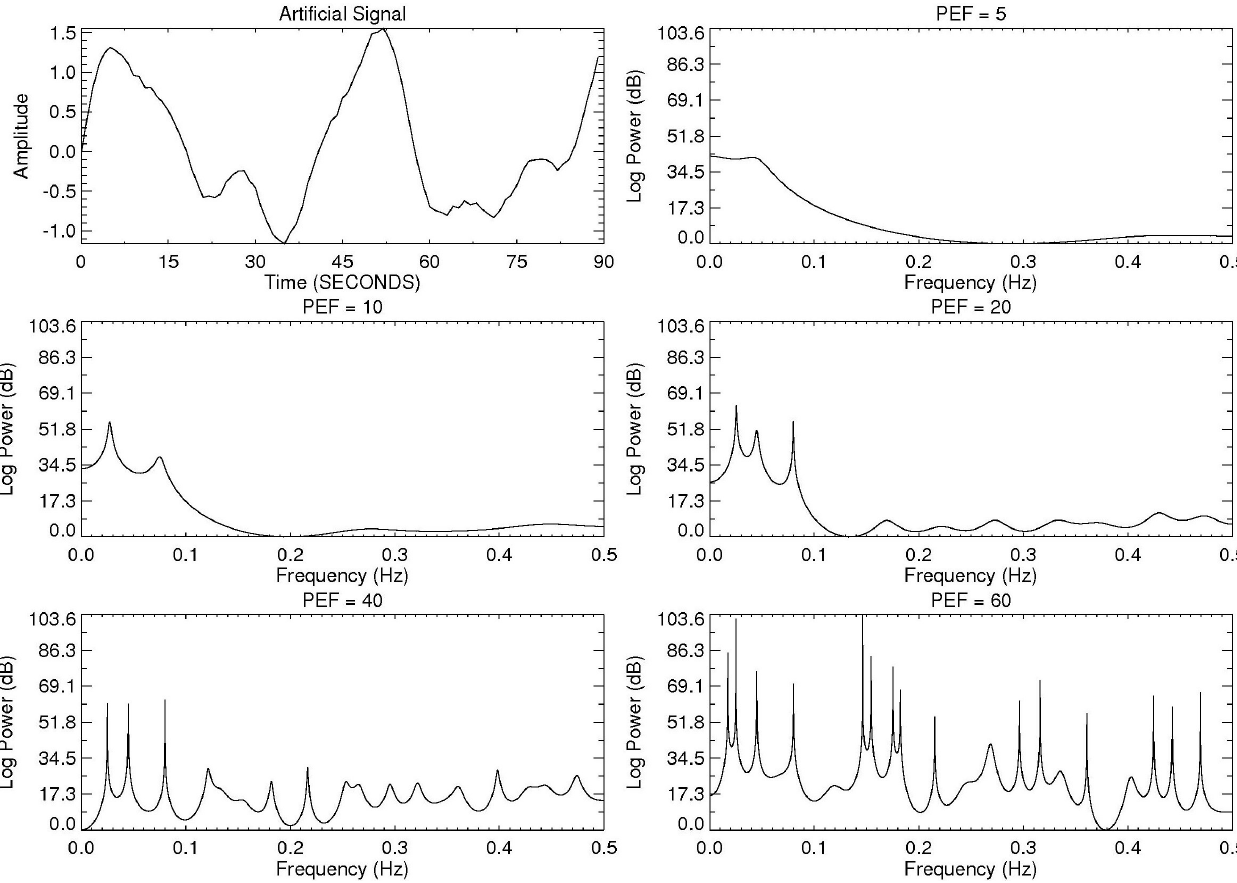
shortcoming of the Fast Fourier Transform (FFT) in ana- lyzing short duration signals is the limited resolving power (Chen and Stegen, 1974). Maximum Entropy Spectral Anal- ysis (MESA) introduced by Burg (1967, 1968) is a nonlin- ear method, for computing spectral estimates. The idea of the method is to choose the spectrum which corresponds to the most random or unpredictable time series of which the auto-correlation function agrees with a set of known